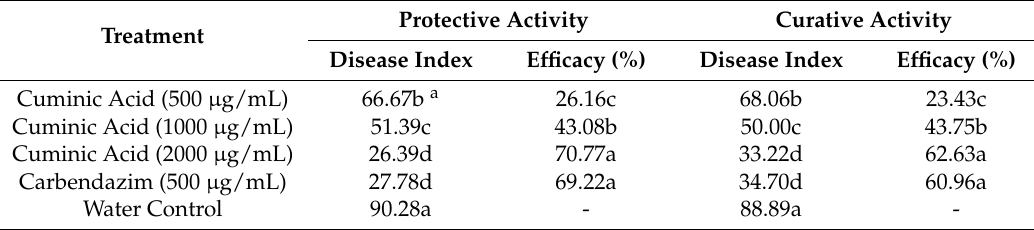
Table 2. Protective and curative activity of cuminic acid against F. oxysporum .